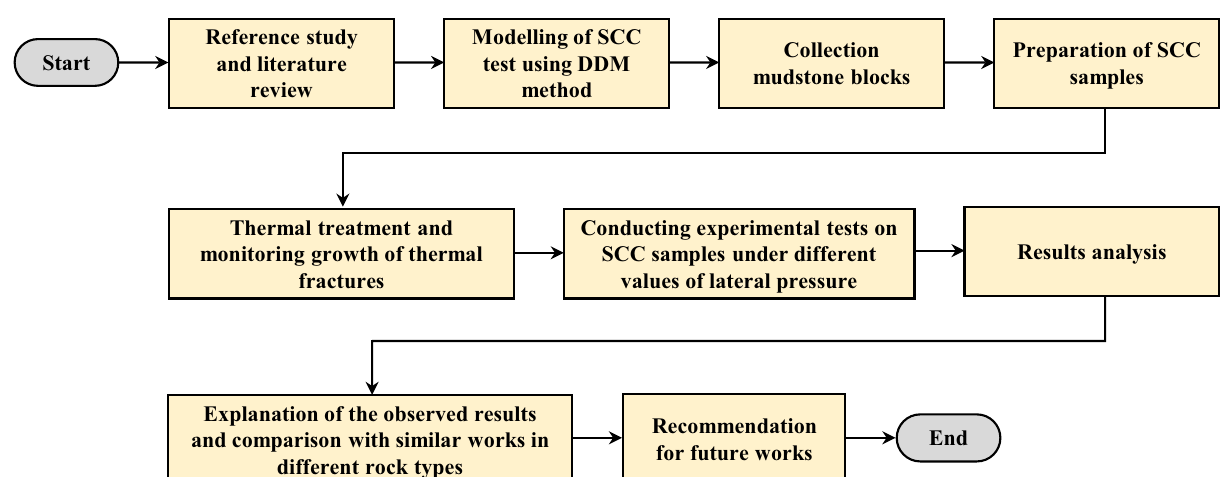
Figure 1. Flow chart visualizing the steps taken to develop this